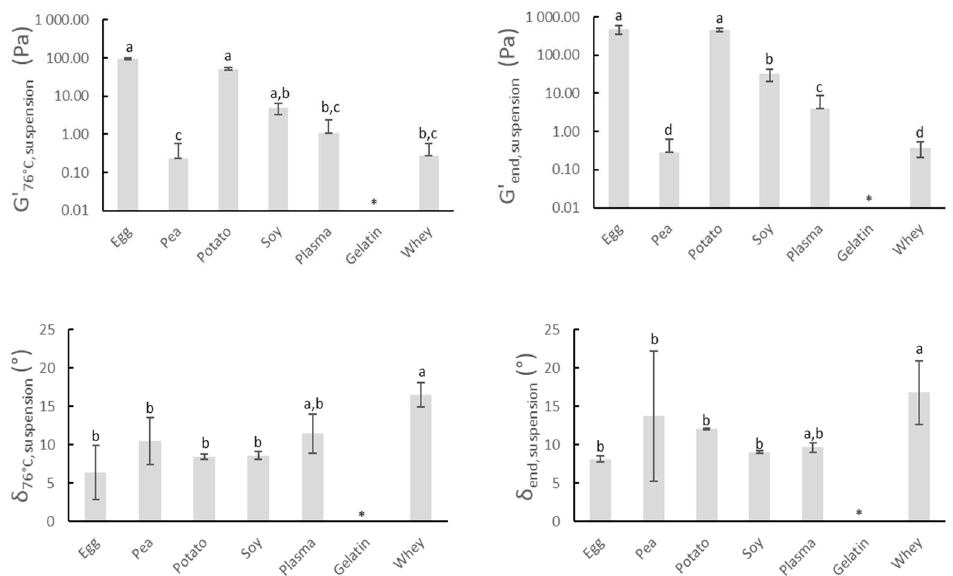
Figure 1. G’ 76 ◦ C,suspension and δ 76 ◦ C,suspension represent the elasticity modulus and phase angle of protein suspensions at the end of the isothermal heating at 76 ◦ C for 3 min. G’ end,suspension and δ end,suspension represent the elasticity modulus and phase angle of protein suspensions after further cooling from 76 to 20 ◦ C. (*) = no value of gelatin could be obtained. Mean values and standard deviations are presented (n = 4). Letters a–d: different letters indicate significant differences ( p < 0.05) between different proteins.